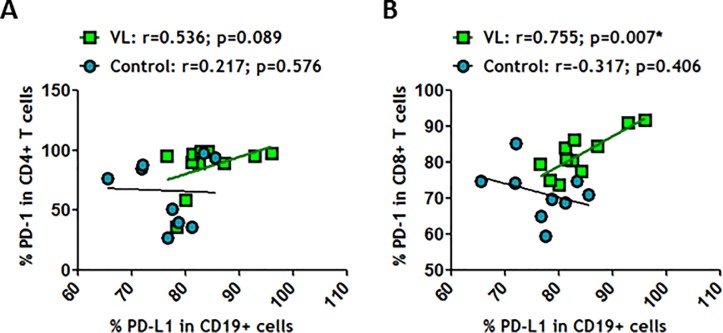
PD-L1-expressing CD19+ correlated positively with PD-1-expressing CD8+ T cells in HIV-1+ individuals.(A) Correlation between frequencies of PD-L1 in CD19+ cells and PD-1 in CD4+ T cells and (B) Correlation between frequencies of PD-L1 in CD19+ cells and PD-1 in CD8+ T cells were determined in healthy individuals and in VL-HIV-1+ individuals. Correlations were determined by Spearman’s rank correlation. * = p<0.05 when comparing conditions. Each symbol corresponds to an individual.